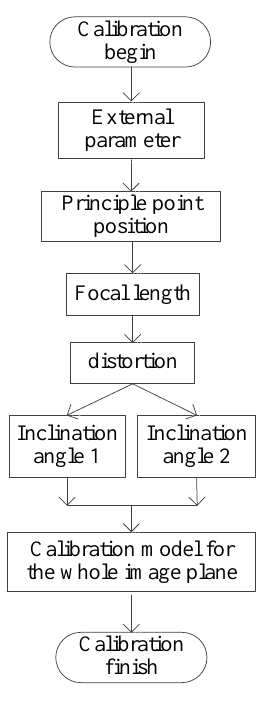
Figure 10. Calibration flow